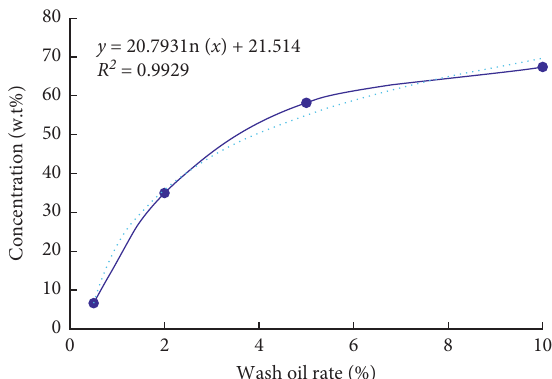
Figure 7: Relationship between different concentrations of PD-7 and oil washing rate.